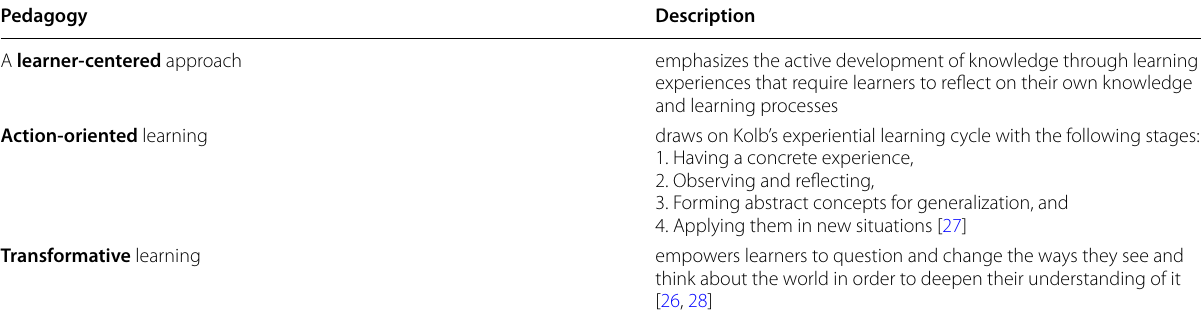
Table 1 Key pedagogies for implementing ESD. Modified from ([6], p. 55)